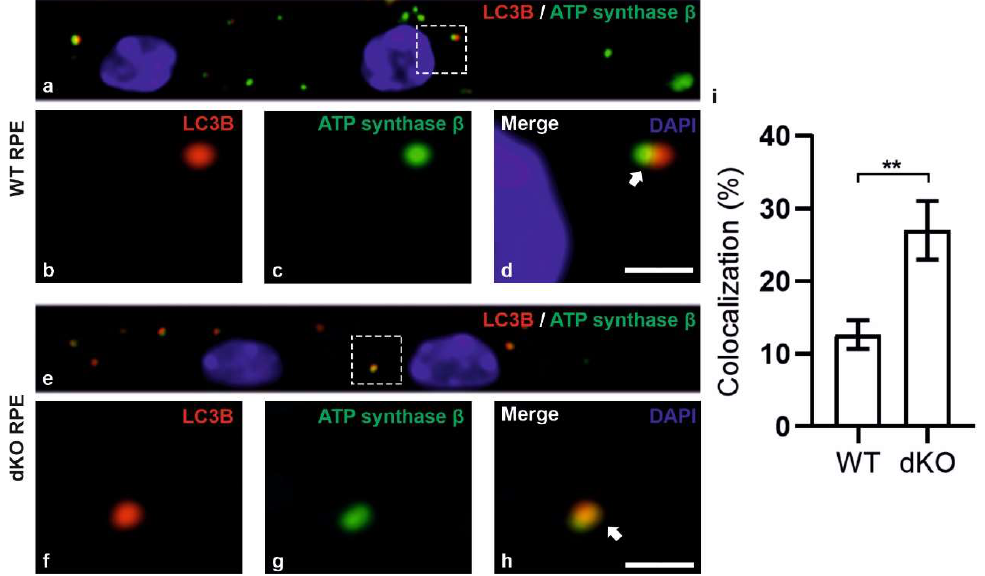
Figure 5. Confocal microscopy analysis of autophagosome marker LC3B and mitochondrial marker ATP synthase β in WT and dKO RPE cells ( a , e ). The colocalization of LC3B ( b , f ) and ATP synthase β ( c , g ) will show the amount of local autophagosome formation. Our image analysis showed a ~158% increase in the LC3B and ATP synthase β colocalization in dKO compared to in WT ( d , h , i ). Scale = 5 µ m. **p <